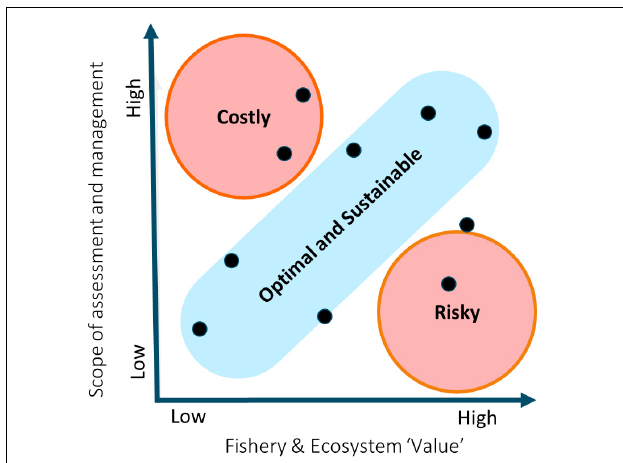
FIGURE 2 | Conceptual risk-reward framework for fisheries